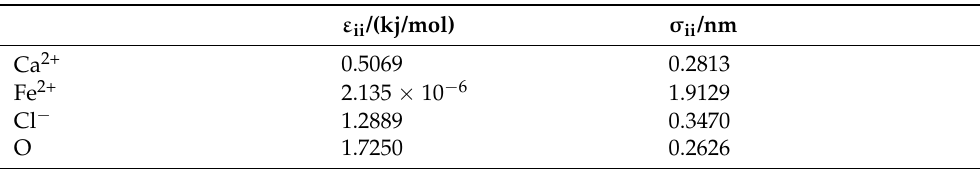
Table 2. The MD simulations employed the Lennard-Jones potential parameters according to the combining rules of Lorentz and Berthelot, i.e., ε ij = ( ε ii ε jj ) 1/2 , σ ij = ( σ ii + σ jj )/2. ε ii